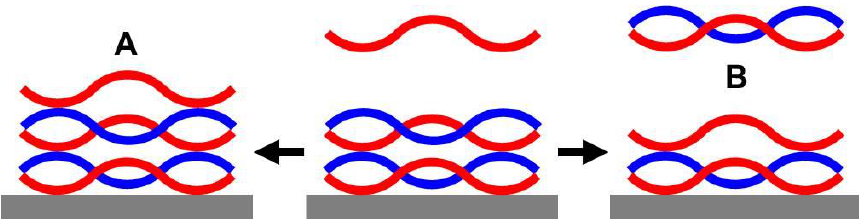
Figure 10. Simplified scheme of the PEM formation process with PEL ad/desorption competition [52] (reprinted by kind permission of the ACS).